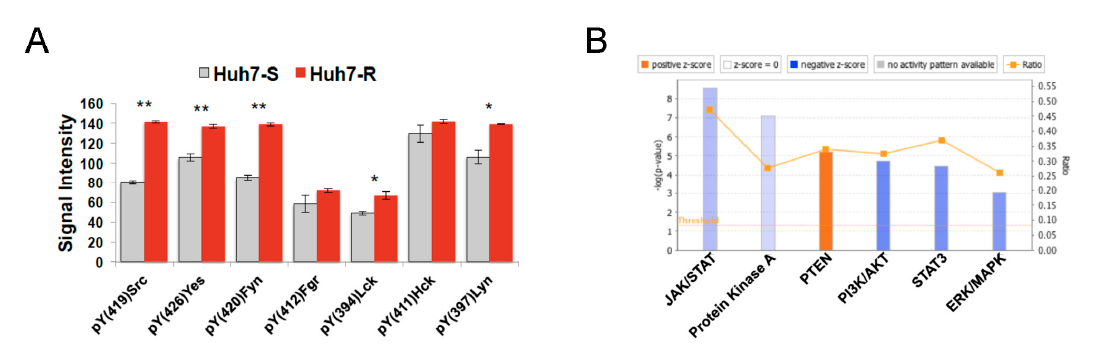
Figure 4. Mechanism of action of predicted drug candidates. ( A ) Enhanced phosphorylation of the Src family of kinases in sorafenib-resistant cells relative to sensitive cells, as measured by the Proteome Profiler Human Phospho-Kinase Array (* p < 0.05, ** p < 0.010, two-tailed t test) at 48 h. ( B ) Ingenuity pathway analysis of gene expression profile from fostamatinib-treated HepG2 cells reveals significantly altered pathways.